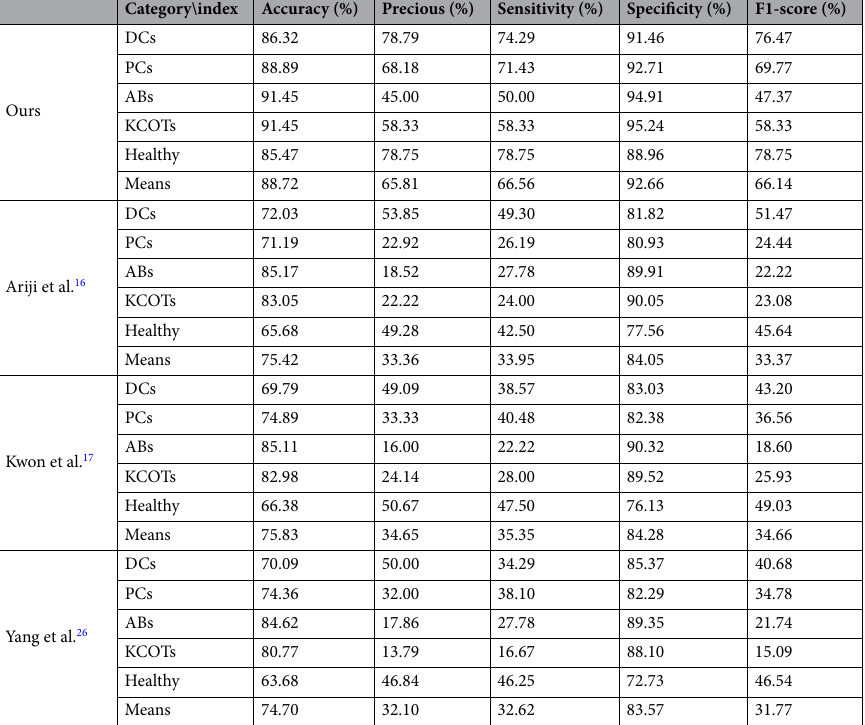
Table 1. The five-class classification performance of cysts, tumors and healthy samples. Our method achieves higher scores than the other three methods on most metrics. For our method, all cysts and tumors have superior accuracy and specificity. Cysts (DCs and PCs) achieve higher sensitivity/recall scores than tumors (ABs and KCOTs).